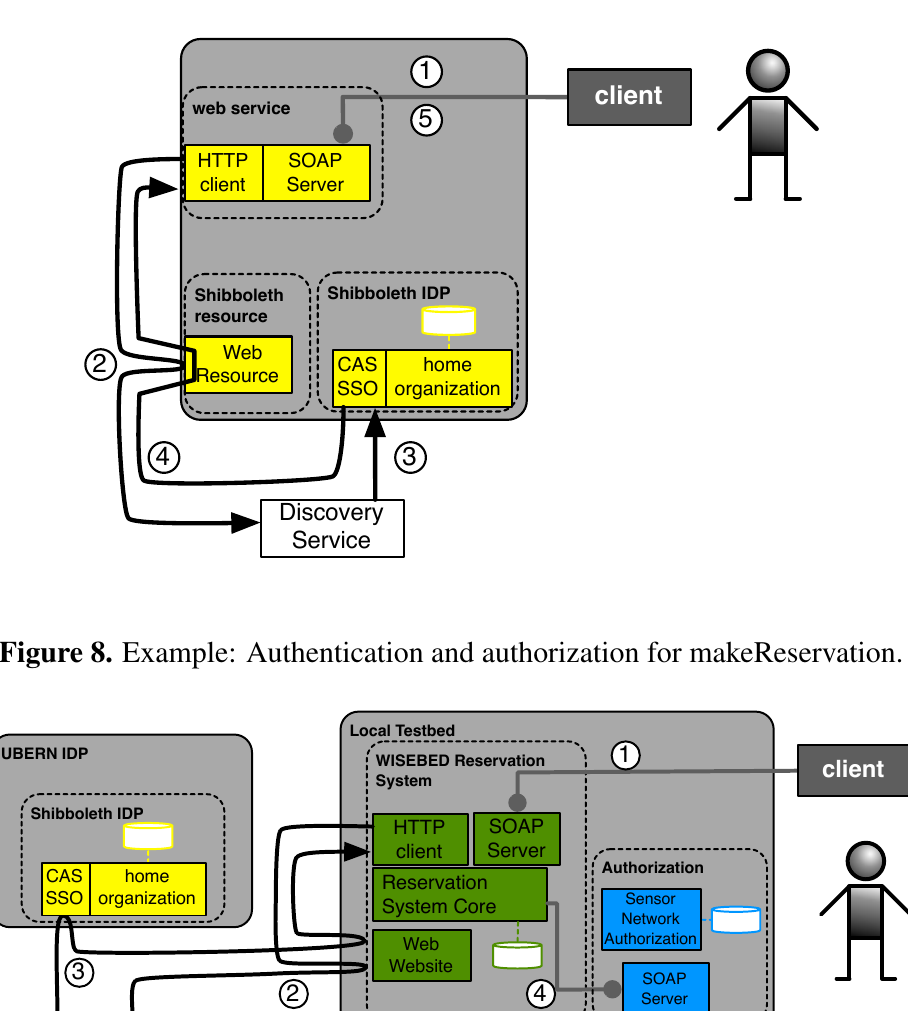
Figure 7. Implementation of authentication web service.